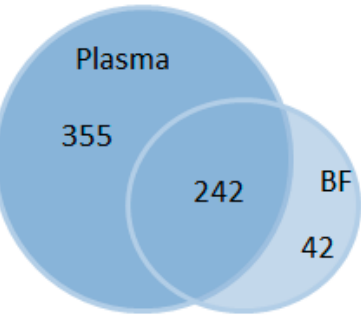
Figure 1. Venn diagram for total numbers of biochemicals in plasma and embryonic blastocoel cavity fluid (BF) in rabbits. 597 biochemicals were detected in total.